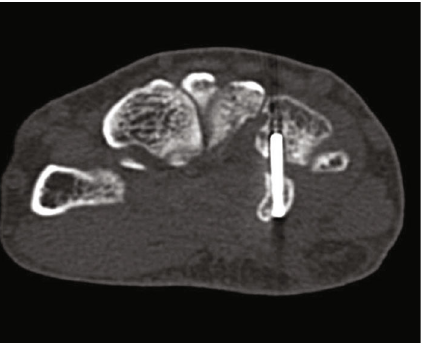
Figure 8: CT scan performed 3 months postoperatively showing the gap at the fracture